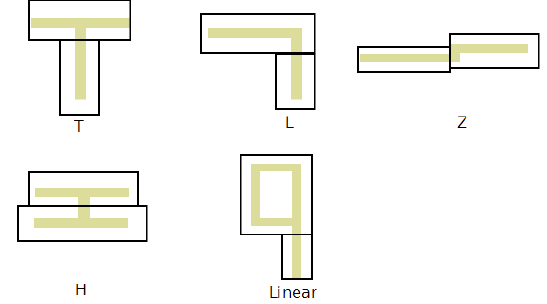
Figure 4. Five kinds of connection ways